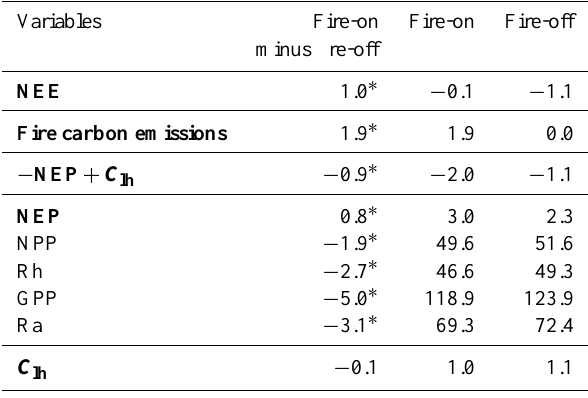
Table 2. The 20th century average of global annual NEE, fire car- bon emissions, net ecosystem production (NEP), NPP, heterotrophic respiration (Rh), GPP, autotrophic respiration (Ra), and carbon loss due to land use and wood harvest ( C lh ) , and − NEP + C lh in fire-on and fire-off simulations and their difference (fire-on minus fire-off) in the two simulations. Fire direct and indirect effects on the mean of the terrestrial carbon balance are quantified by the difference in fire carbon emissions and –NEP + C lh , respectively. Units are Pg where NEP = NPP–Rh and NPP = GPP–Ra.